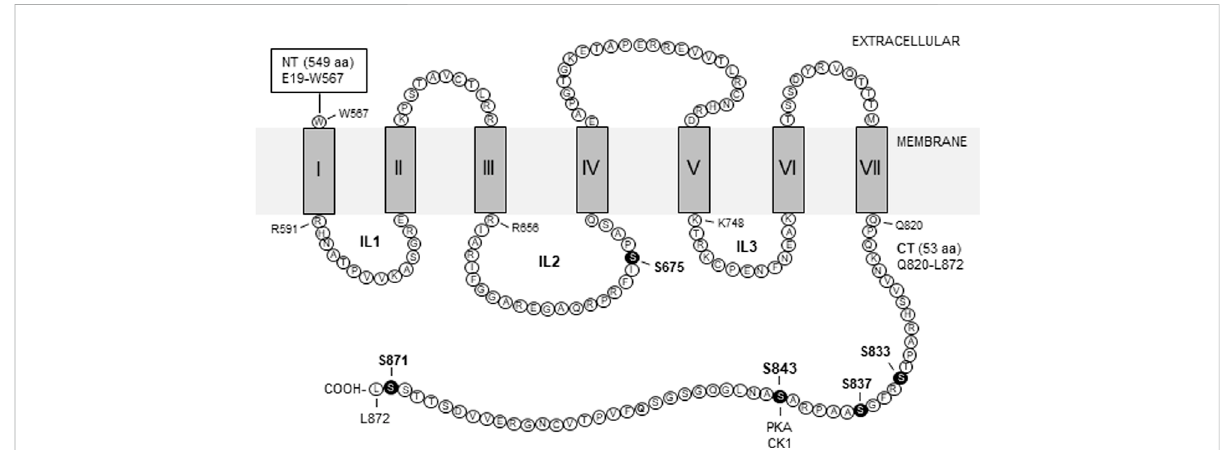
FIGURE 1 SchematicillustrationoftransmembranetopologyofratmGlu2receptors.Theillustratedregionsincludeseventransmembranedomains(I-VII) and four intracellular domains, i.e., the intracellular loop 1 (IL1), IL2, IL3, and C-terminus (CT). Amino acid sequences of intracellular domains are labeled by the single letter code (accession #: NP_001099181/NCBI; P31421/UniProtKB). Note that all intracellular domains contain serine and/or threonine but not tyrosine residues. Solid circles indicate the serine sites where variable levels of phosphorylation have been detected. Other abbreviations: CK1, casein kinase 1; NT, N-terminus; PKA, protein kinase